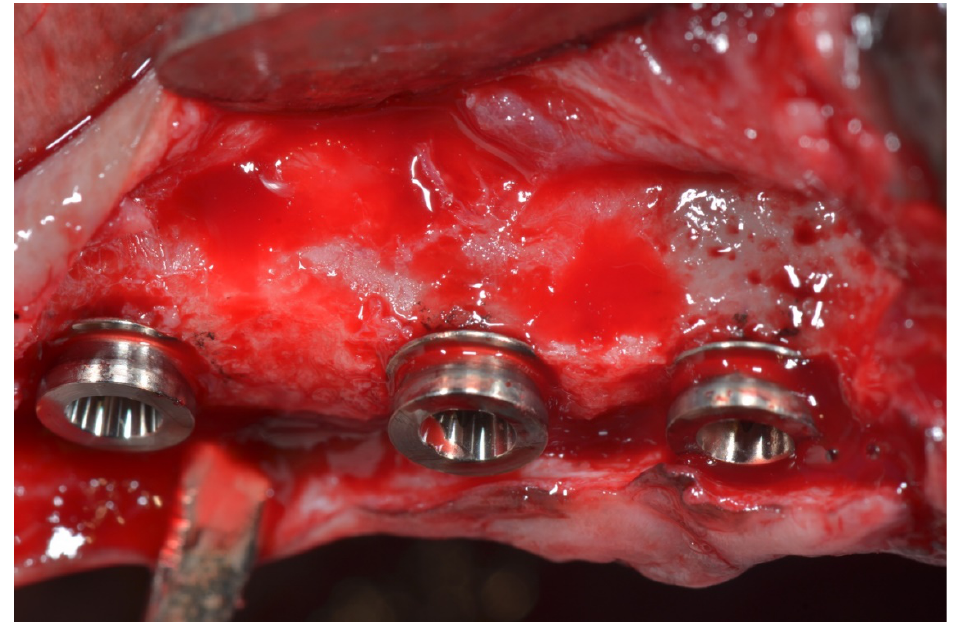
Figure 3. Clinical approach of wide and narrow ring extra-short implants installed in maxilla.